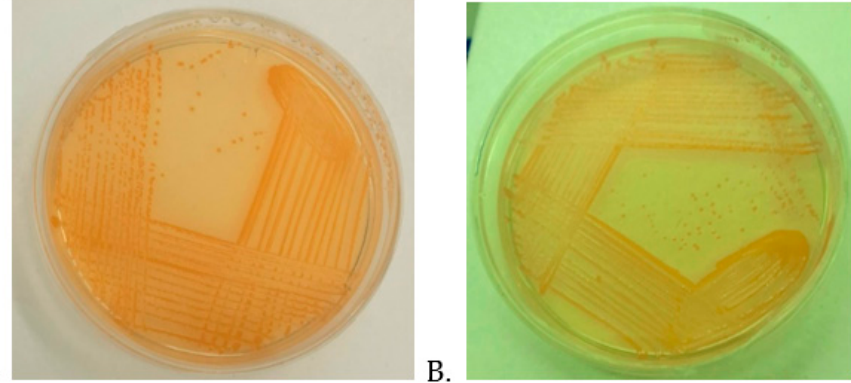
Figure 1. Colony morphology of ( A ) P. aminophilus CRT1 and ( B ) P. kondratievae CRT2 (LB agar) .